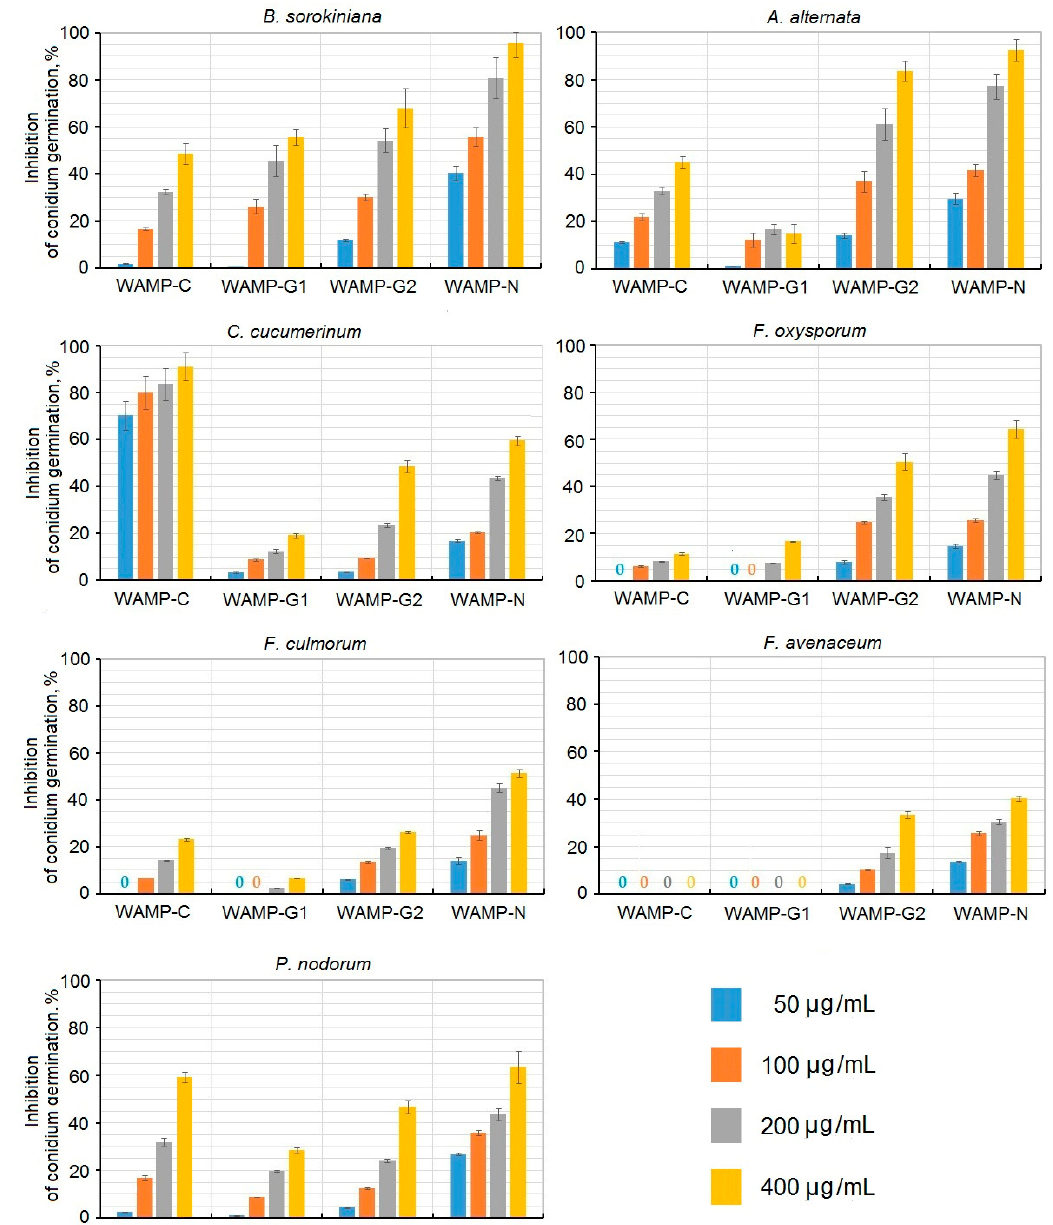
Figure 5. Suppression of spore germination in seven plant pathogenic fungi by WAMP-2-derived peptides. Average means of three experiments for each pathogen and SD are shown. Table 3. Antifungal activity of WAMP-2-derived peptides.